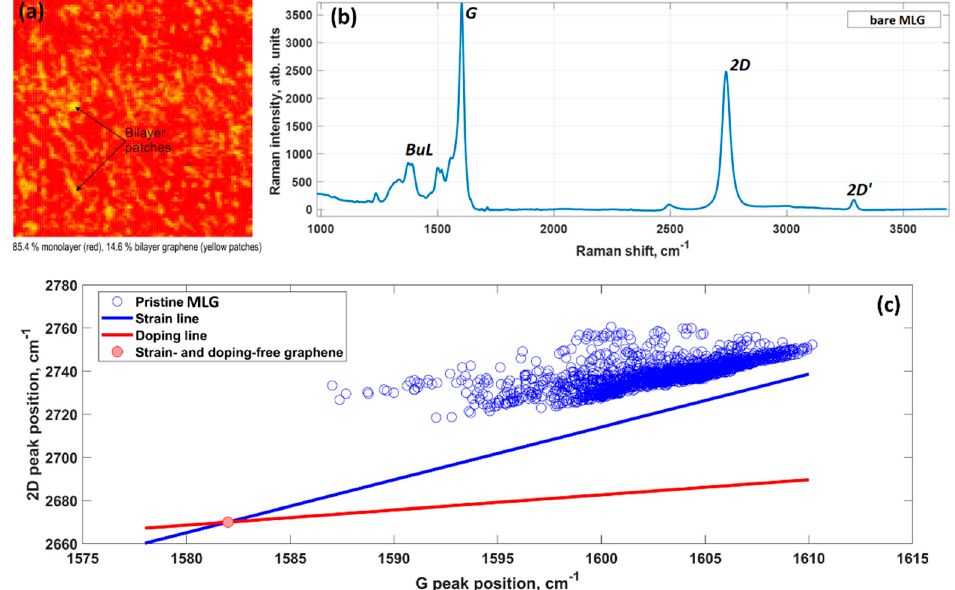
Figure 2. ( a ) The optical reflectance map confirming the prevalence of monolayer graphene on a 30 × 30 μ m 2 area. Bilayer patches are seen in yellow. ( b ) Raman spectrum of typical monolayer epitaxial graphene sample. BuL represents the spectral features related to the buffer layer. ( c ) Dependence of 2 D peak position on G peak position. The above figures have been adapted with permission from [42]. Copyright 2021 The Authors. Published by American Chemical Society, Washington, United States. Further permissions related to the material excerpted should be directed to the ACS, Washington, United States.